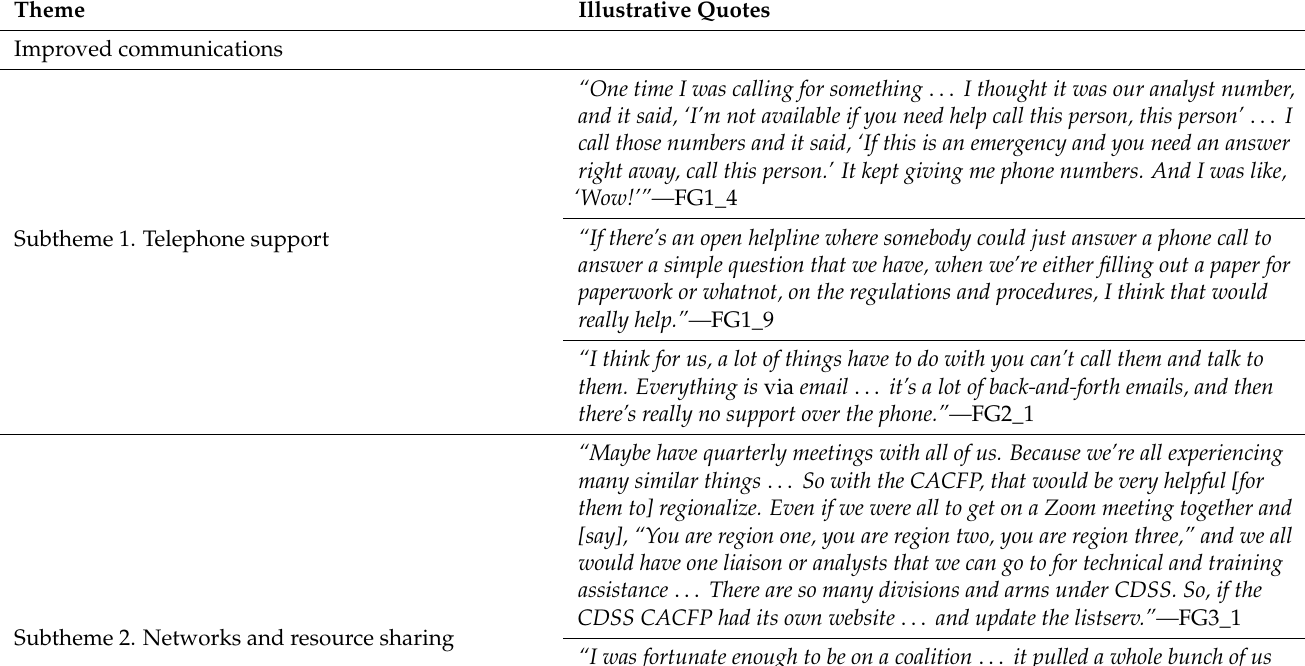
Table 8. Emergent themes of facilitators to participating in the CACFP 1